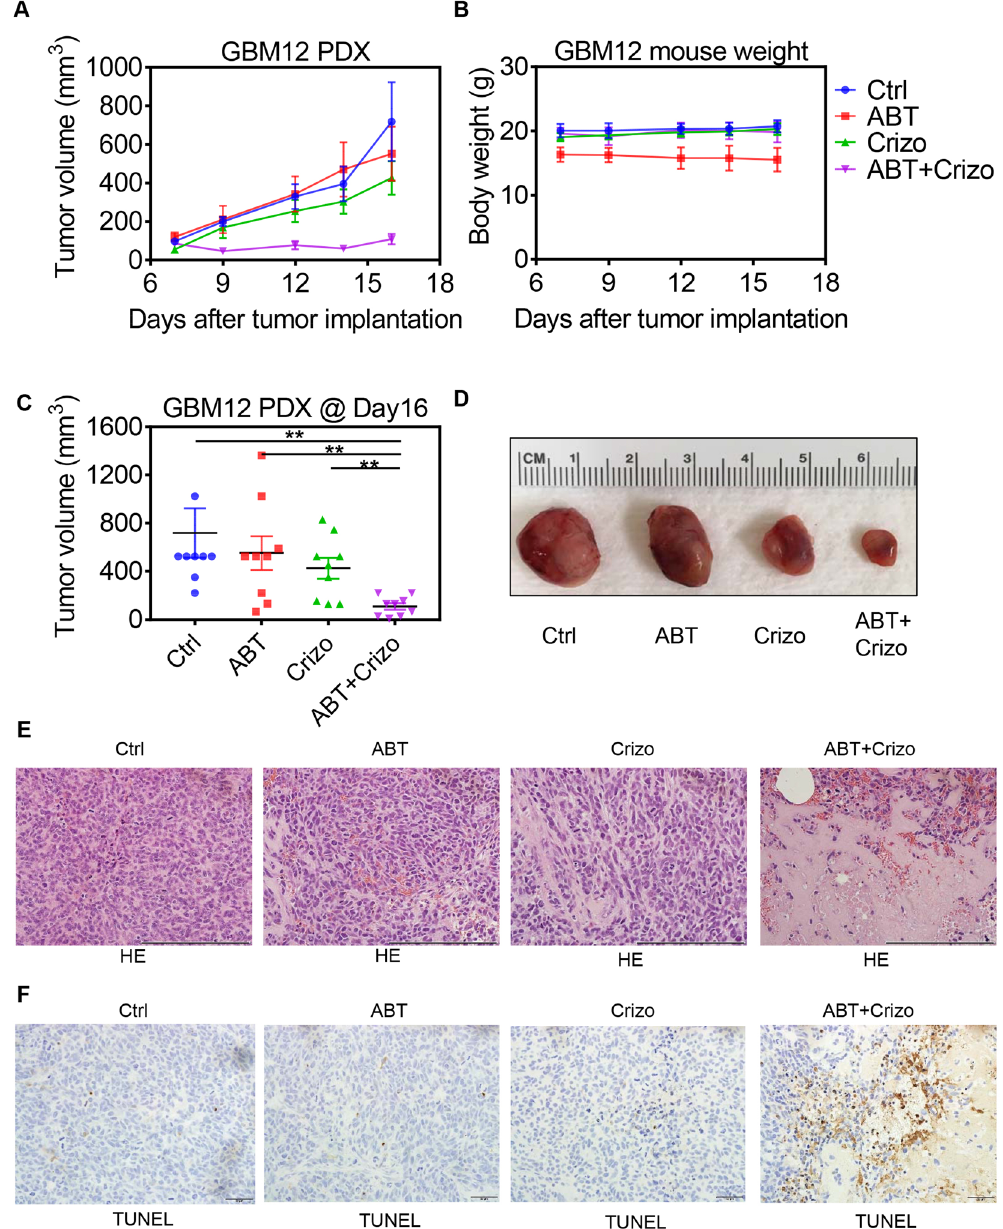
Figure 6. Dual inhibition of c-MET and Bcl-2/Bcl-xL leads to enhanced tumor growth suppression in a PDX model of GBM. ( A ) GBM12 PDX cells were implanted into the subcutis of immunocompromised Nu/Nu mice. After tumors were established (palpable), randomization was performed to assign four distinct treatment groups. These groups are designated as: Control; ABT263 (ABT) (75 mg/kg); Crizotinib (Crizo) (50 mg/kg) and ABT263 + Crizotinib (ABT + Crizo). Shown are tumor volumes over time. Values are means and SD. n = 9 in each group. ( B ) The indicated groups were assessed for body weight. Shown are means and SD. ( C ) Shown is the last measurement as a dot-plot (means and SD) with corresponding statistical analysis. n = 9. ( D) Gross images of representative tumors from each individual group at day 16. ( E ) Tumors were resected and fixed in formalin according to standard operating procedure. Thereafter, they were embedded in paraffin, cut and stained with conventional H.E. staining. A scale bar accompanies each image (200 μ m). Ctrl: Vehicle, ABT: ABT263. Crizo: Crizotinib, ABT + Crizo: ABT263 + Crizotinib. ( F ) The tumors were stained with TUNEL and photographs were taken. Scale bar indicates 50 μ